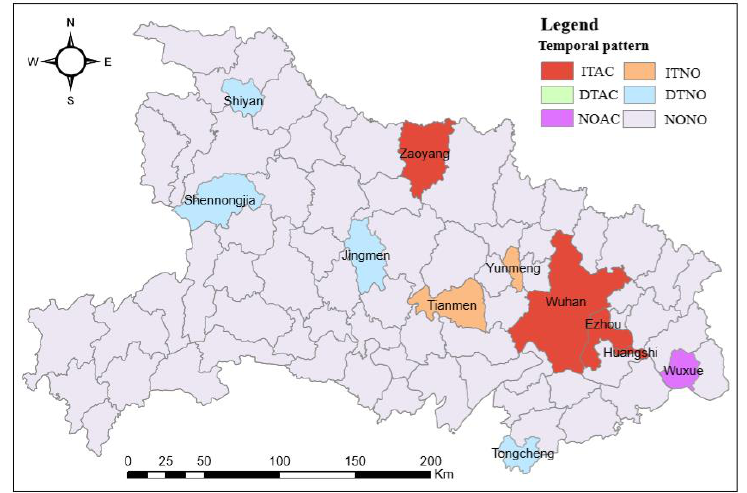
Figure 3. Temporal patterns of the number of daily new confirmed cases.